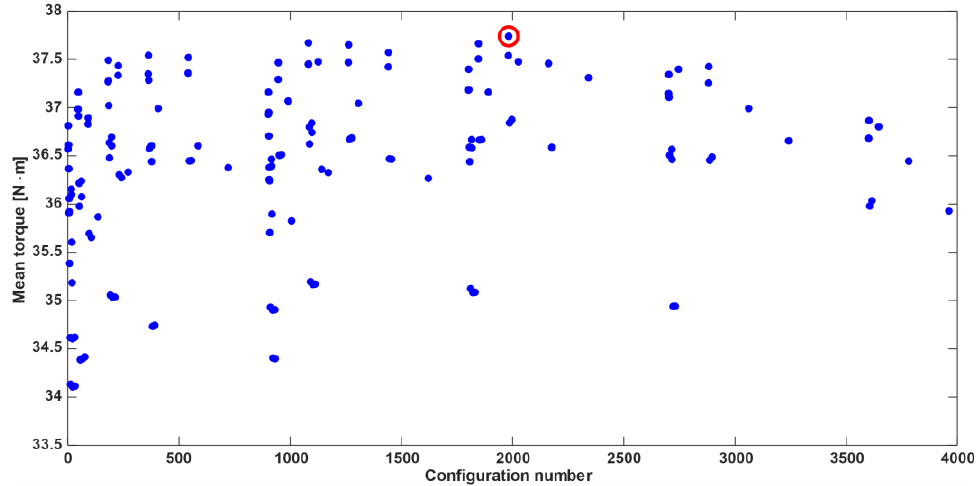
Figure 6. Values of mean torque for the 154 selected configurations (the maximum value, 37.74 N·m, is circled in red).